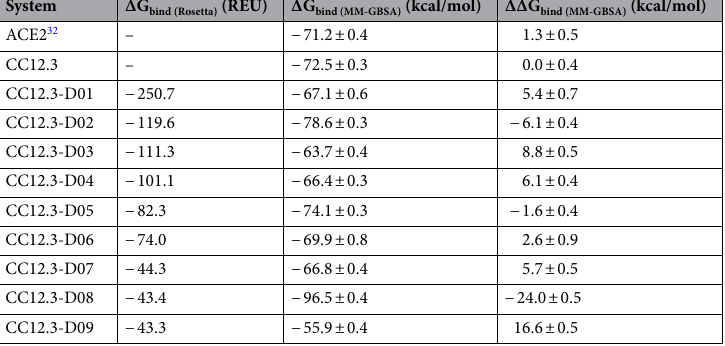
lations were performed on the structures of Fab CC12.3 and the nine designed Fabs CC12.3 in complex with SARS-CoV-2-RBD. The RMSD values of all atoms and backbone atoms were calculated to analyze structural stabilities of all systems. Figure S1 shows that all systems are likely to be stable in the range of 80–100 ns based on their RMSD values; therefore, these trajectories were used for further analyses. The values of ΔG bind (MM-GBSA) of all systems during the 80–100 ns trajectories were calculated to predict the binding affinities of all systems. As shown in Table 2, the values of ΔG bind (MM-GBSA) of Fab CC12.3/SARS-CoV-2-RBD complex is − 72.5 ± 0.3 kcal/ mol. Three of nine designed Fabs CC12.3 such as CC12.3-D02, CC12.3-D05, and CC12.3-D08 have better ΔG bind (MM-GBSA) than CC12.3 with ΔΔG bind (MM-GBSA) of − 6.1 ± 0.4, − 1.6 ± 0.4, and − 24.0 ± 0.5 kcal/mol, respec- tively. Moreover, the predicted binding affinities of CC12.3, CC12.3-D02 (ΔG bind (MM-GBSA) = − 78.6 ± 0.3 kcal/mol), The structures of Fab CC12.3 and the three best designed Fabs CC12.3 binding to SARS-CoV-2-RBD with better predicted binding affinities than Fab CC12.3 and ACE2 are illustrated in Fig. 1. Overall, the binding posi- tions and orientations of CC12.3-D02, CC12.3-D05, and CC12.3-D08 to SARS-CoV-2-RBD are relatively similar to that of Fab CC12.3. However, CDR H3 in the heavy chain of Fab CC12.3 was redesigned to have various chain